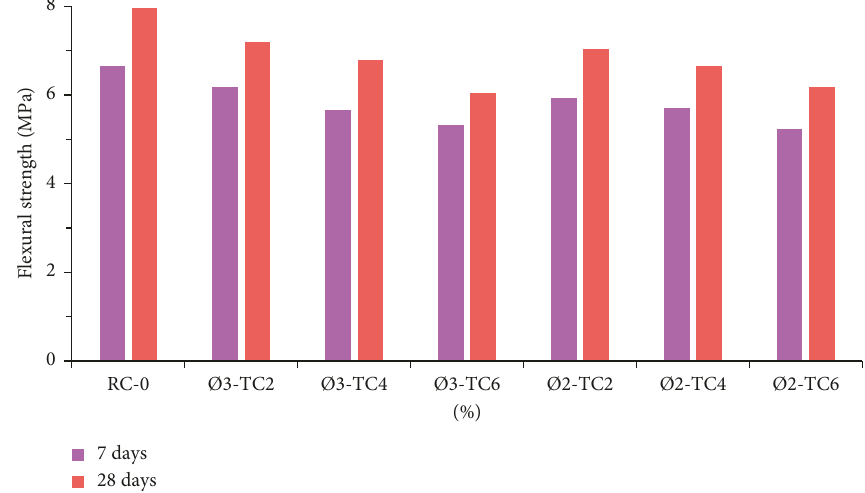
Figure 6: Flexural strength of the translucent concrete at 7 days and 28 days.